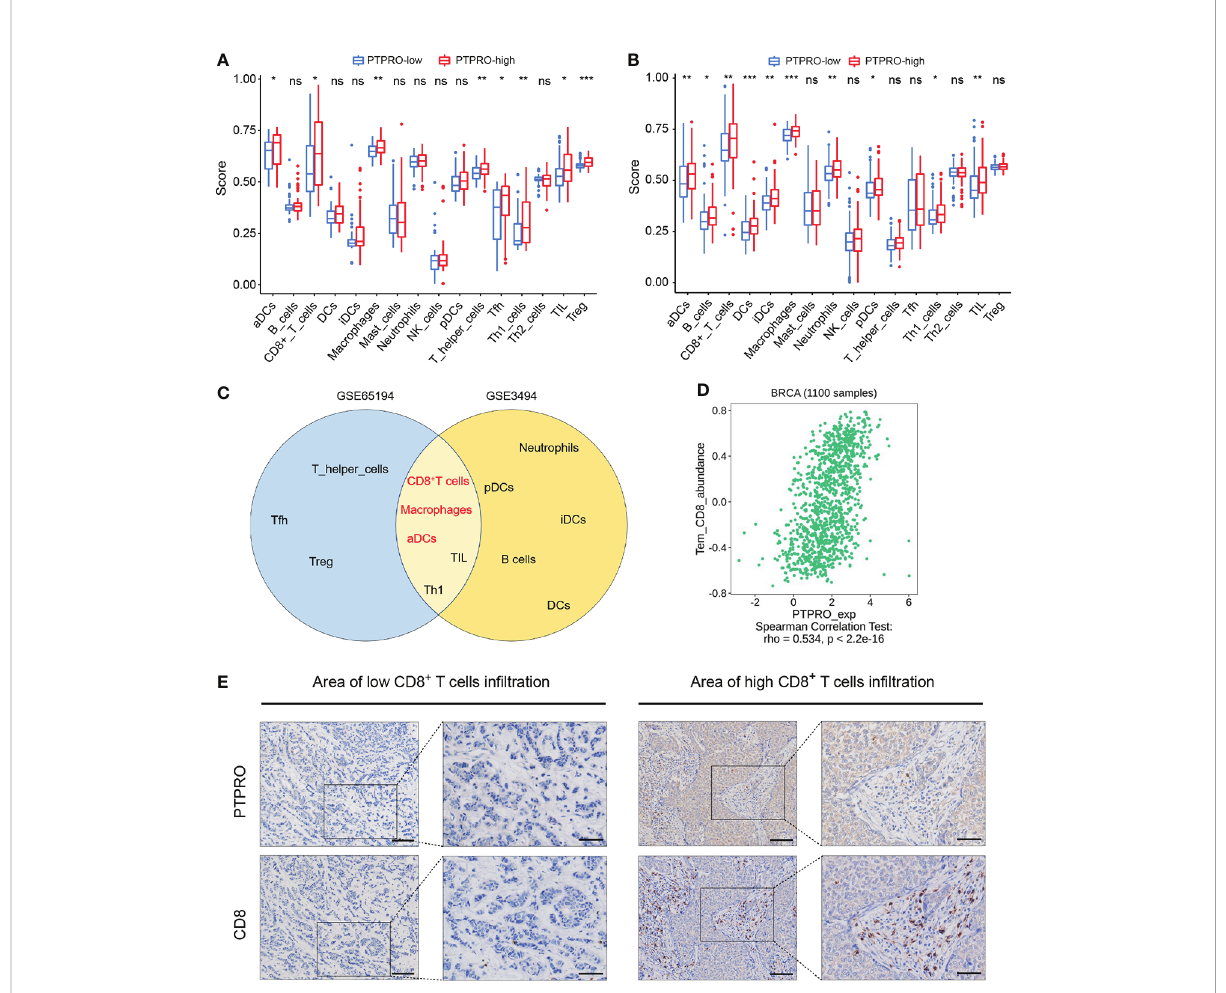
FIGURE 2 Characterization of protein tyrosine phosphatase receptor type O (PTPRO) in breast cancer tumor microenvironment. Comparison of the ssGSEA scores between the PTPRO-high group and the PTPRO-low group in the GSE65194 (A) and GSE3494 (B) cohorts. (C) Overlapped immune cell types correlated with PTPRO expression in the two cohorts. (D) The dot plots displayed the correlations between PTPRO expression and the in fi ltration pattern of CD8 + T cells in TISIDB. (E) Representative IHC staining indicates higher PTPRO levels correlated with increased CD8 + T-cell in fi ltrates in human breast cancer. Scale bars: 100 m m (left panel), 50 m m (right panel). ns, not signi fi cant; * P < 0.05; ** P < 0.01; *** P < 0.001 by Student ’ s t